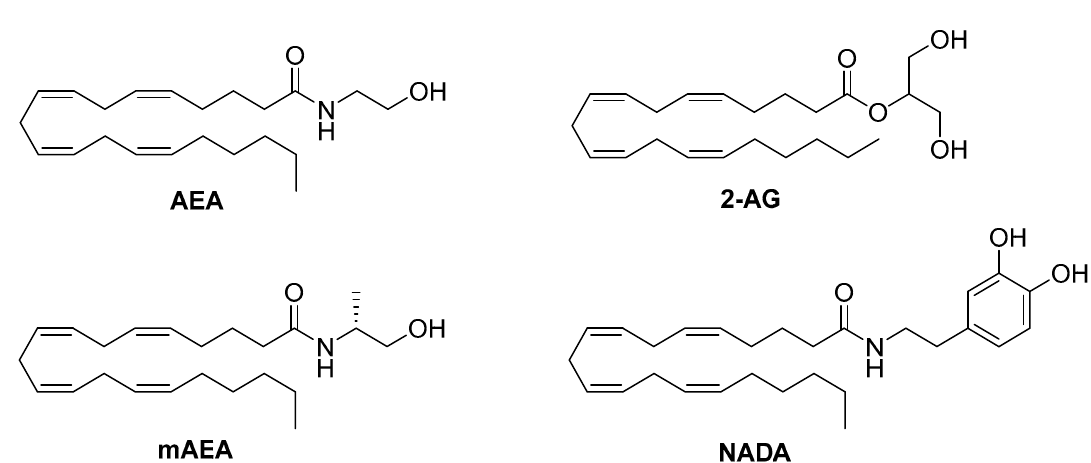
Int. J. Mol. Sci. 2019 , 20 , x FOR PEER REVIEW 13 of 24 Figure4. StructuresoftheCB1functionally-selectiveendocannabinoidsAEA,2-AG,mAEA,andNADA. Figure 4. Structures of the CB1 functionally-selective endocannabinoids AEA, 2-AG, mAEA, and NADA.